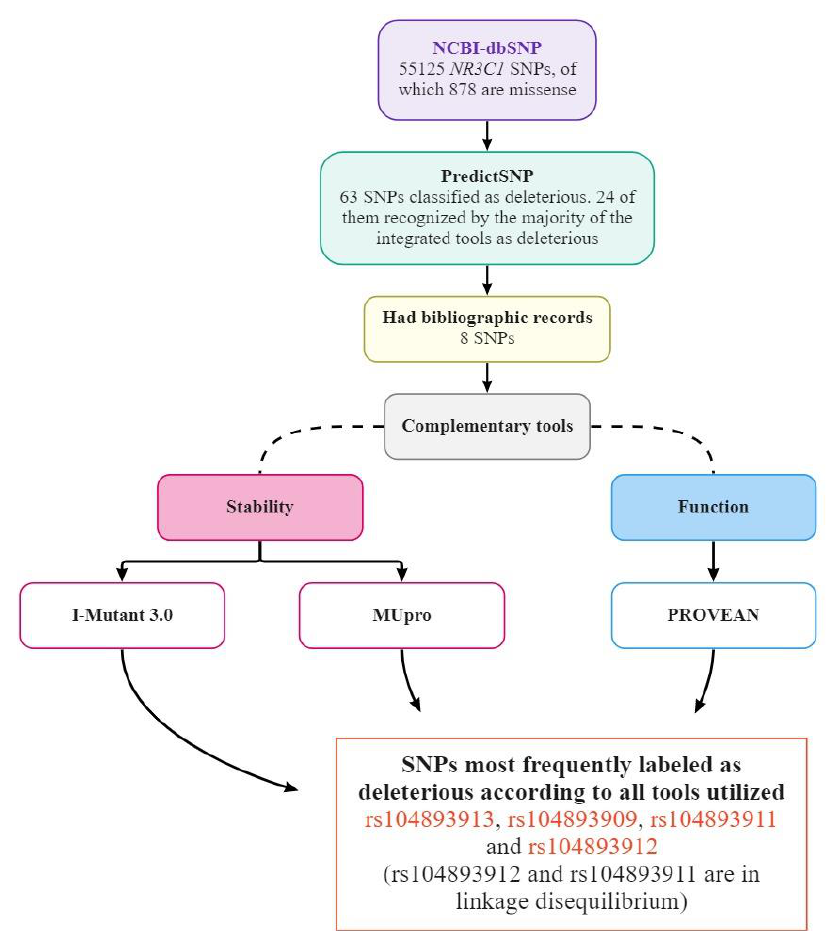
Figure 1. Flowchart of the sequence of in silico analysis of the SNPs of the NR3C1 gene with tools analyzing the effects caused in the proteins by the exchanges of amino acids, induced by missense SNPs (elaborated upon by the authors).